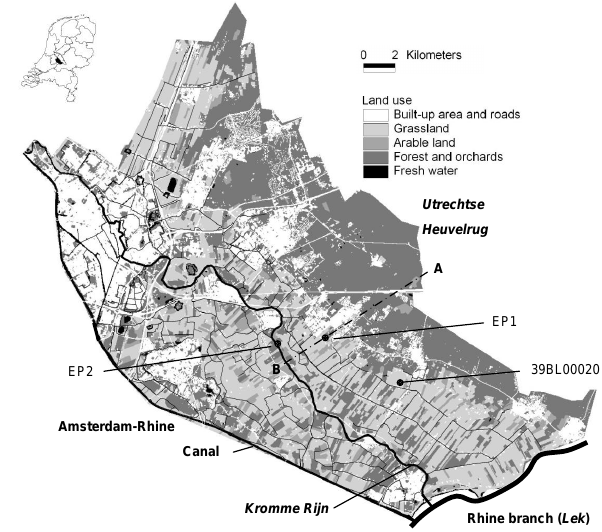
Figure 5. Kromme Rijn region. 2 Fig. 5. Kromme Rijn